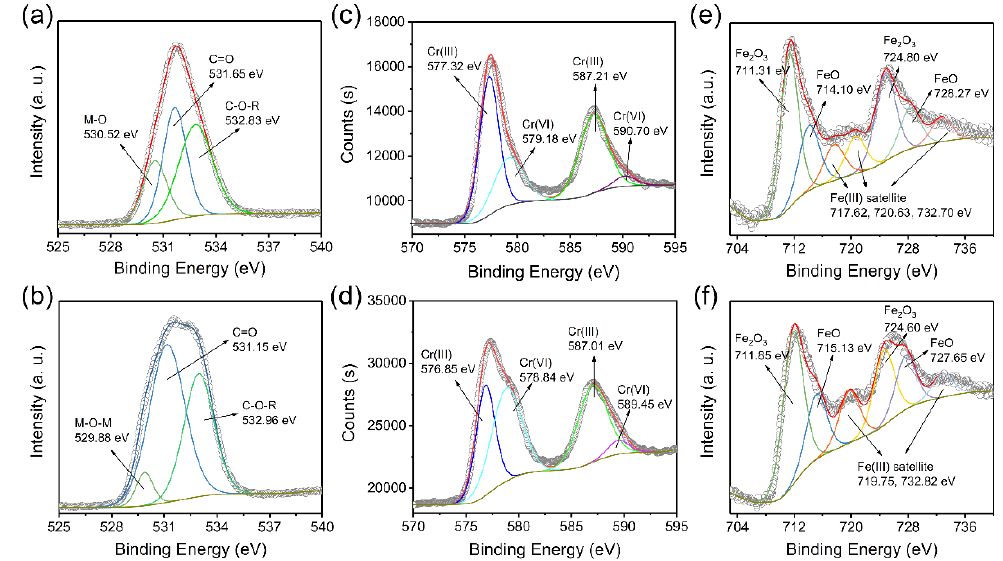
Figure 7. High-resolution XPS spectra of O 1s, Cr 2p, and Fe 2p for Cr(VI) adsorbed on nZVI – BC ( a , c , e ) and C – nZVI – BC ( b , d , f ).